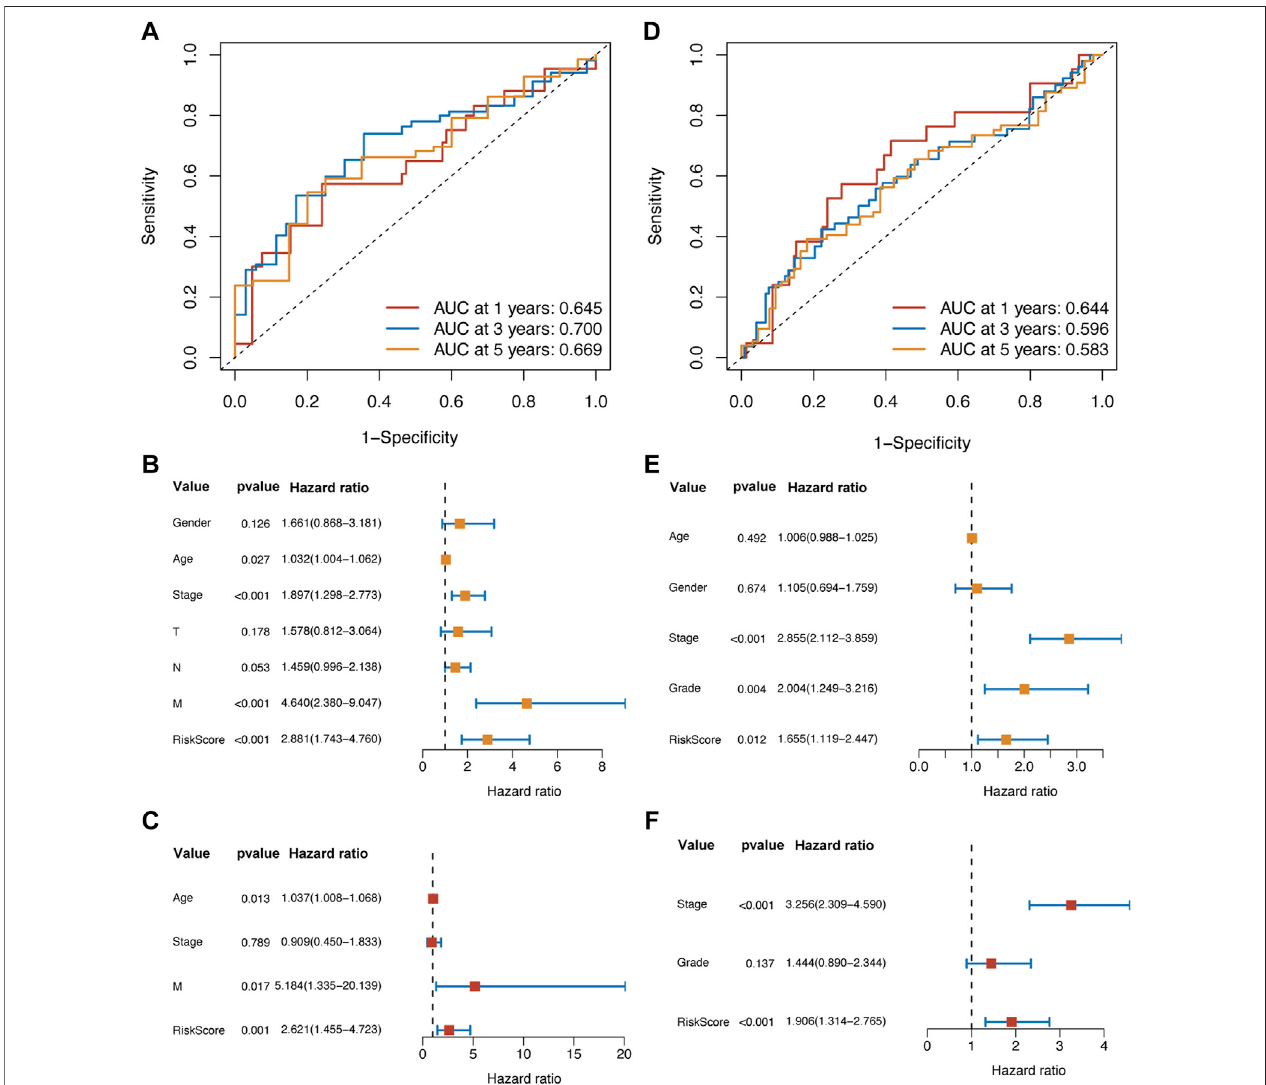
FIGURE 4 | The ROC analysis suggested that the prognostic ability of the risk score model was valuable and stable in different survival durations in the training set (A) and validation set (D) . In the training set, the univariate (B) and multivariate Cox (C) analysis showed that the risk score was an independent prognostic factor. Meanwhile, the results of Cox analysis in the validation set (E,F) were following those in the training set.